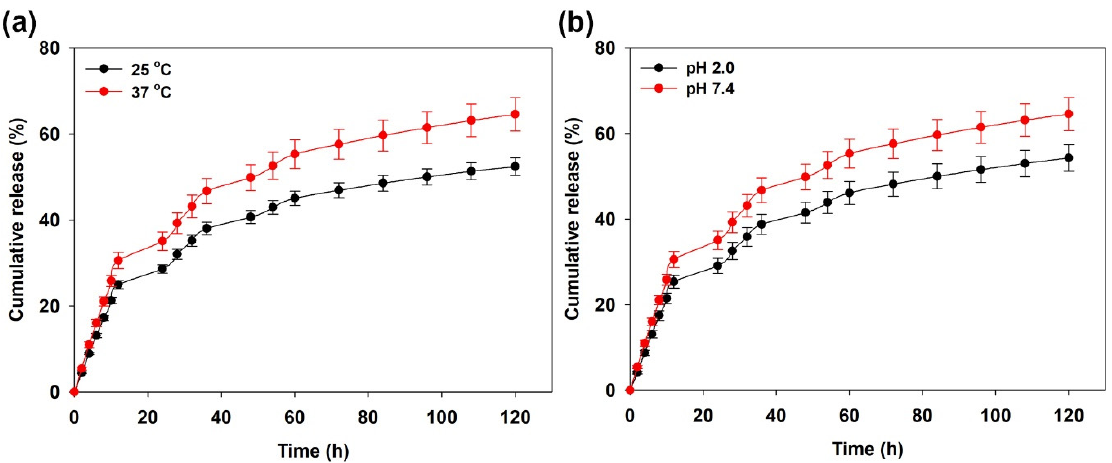
Figure 9. 5-FU cumulative release curves of the prepared hydrogels at different temperatures ( a ) and pH ( b ). pH ( b